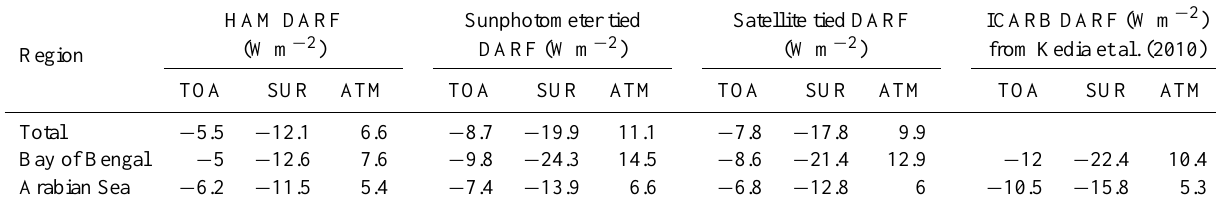
Table 7. Mean clear-sky short-wave direct aerosol radiative forcing (DARF, Wm − 2 ) at the top of the atmosphere (TOA), at the surface (SUR), and within the atmosphere (ATM) over the Bay of Bengal and Arabian Sea regions during ICARB obtained from present study in comparison with earlier studies. HAM DARF Sunphotometer tied Satellite tied DARF ICARB DARF (Wm − 2 ) (Wm − 2 ) DARF (Wm − 2 ) (Wm − 2 ) from Kedia et al. (2010) Region TOA SUR ATM TOA SUR ATM TOA SUR ATM TOA SUR ATM Total − 5.5 − 12.1 6.6 − 8.7 Bay of Bengal − 5 − 12.6 Arabian Sea − 6.2 − 11.5 5.4 −